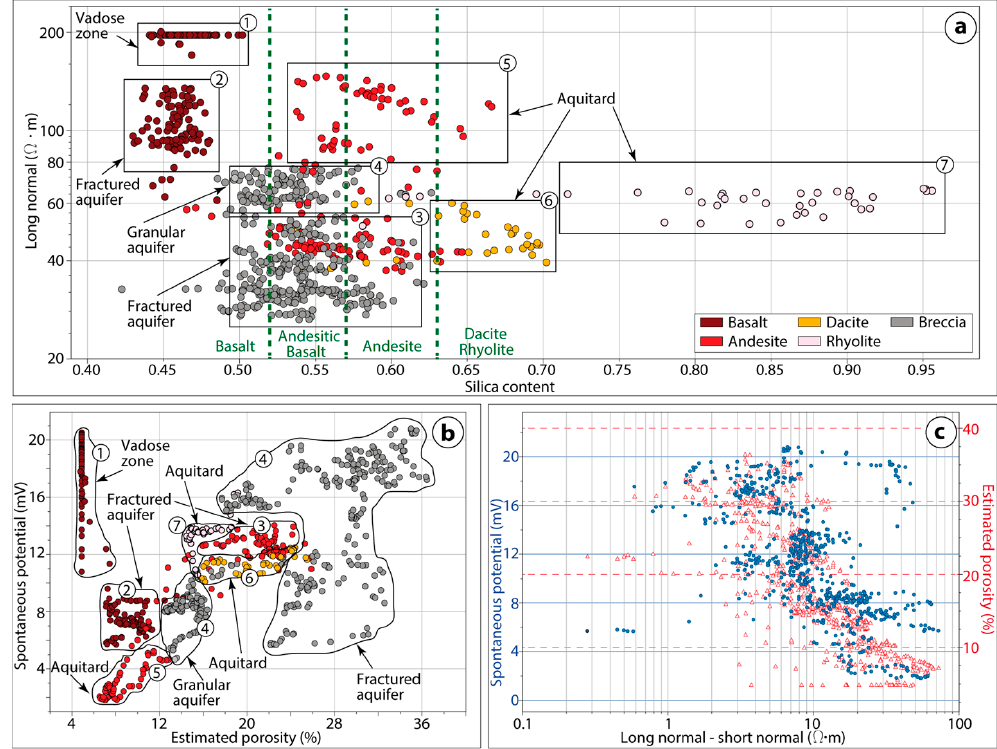
Figure 5. Cross ‐ plots and petrophysical signatures. ( a ) Silica content vs. Long normal resistivity; ( b ) Porosity vs. Spontaneous potential; ( c ) Long normal—Short normal resistivity vs. Spontaneous potential vs. total porosity. For parts ( a , b ): (1) Massive basalt; (2) fractured basalt; (3) fractured andesite; (4) andesitic breccia; (5) massive andesite; (6) dacite; and (7) rhyolite. Seven lythofacies were identified attending to these criteria: (1) massive basalt; (2) fractured basalt; (3) fractured andesite; (4) andesitic breccia (both granular and fractured); (5) massive andesite; (6) dacite; and (7) rhyolite. Lythofacies provide the basis for the identification of the following